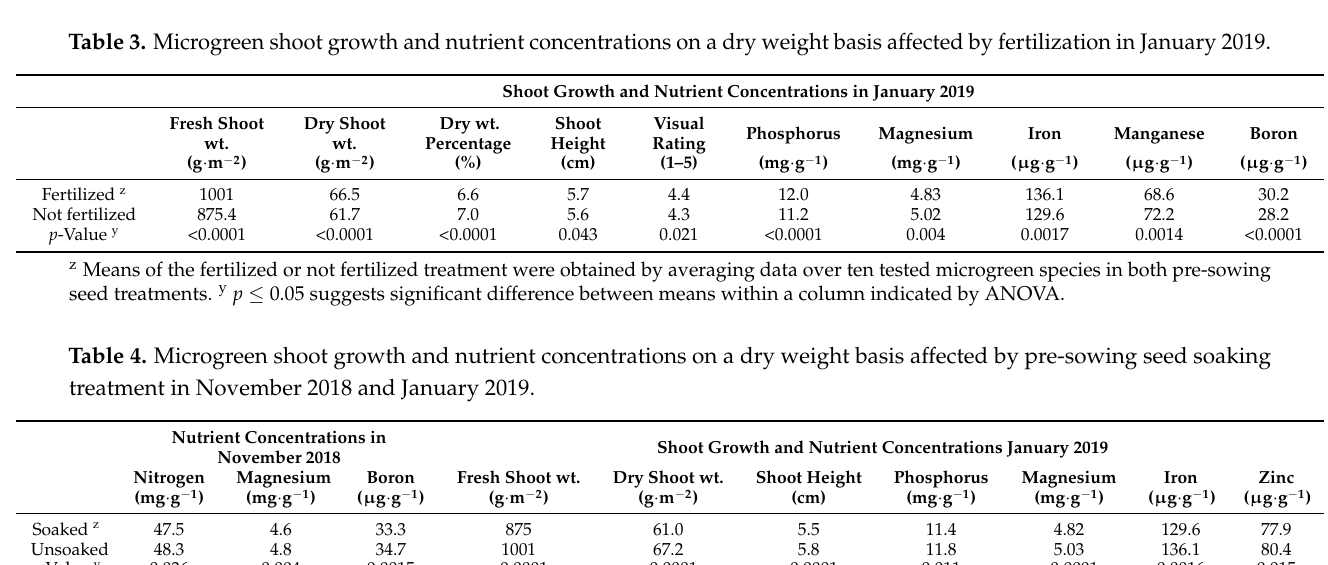
Nitrogen Magnesium Boron Fresh Shoot wt. Dry Shoot